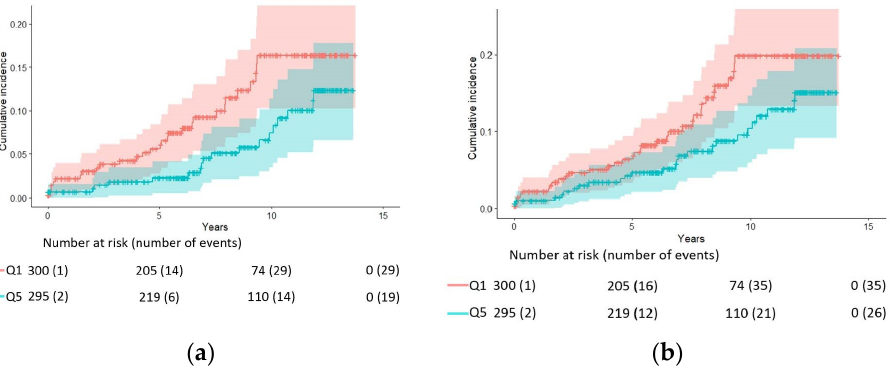
Figure 3. Crude cumulative Alzheimer’s disease ( p = 0.04) ( a ) and all-cause dementia ( p = 0.07) ( b ) in participants with baseline red blood cell DHA in the upper quintile (Q5) compared with those in the lowest one (Q1).